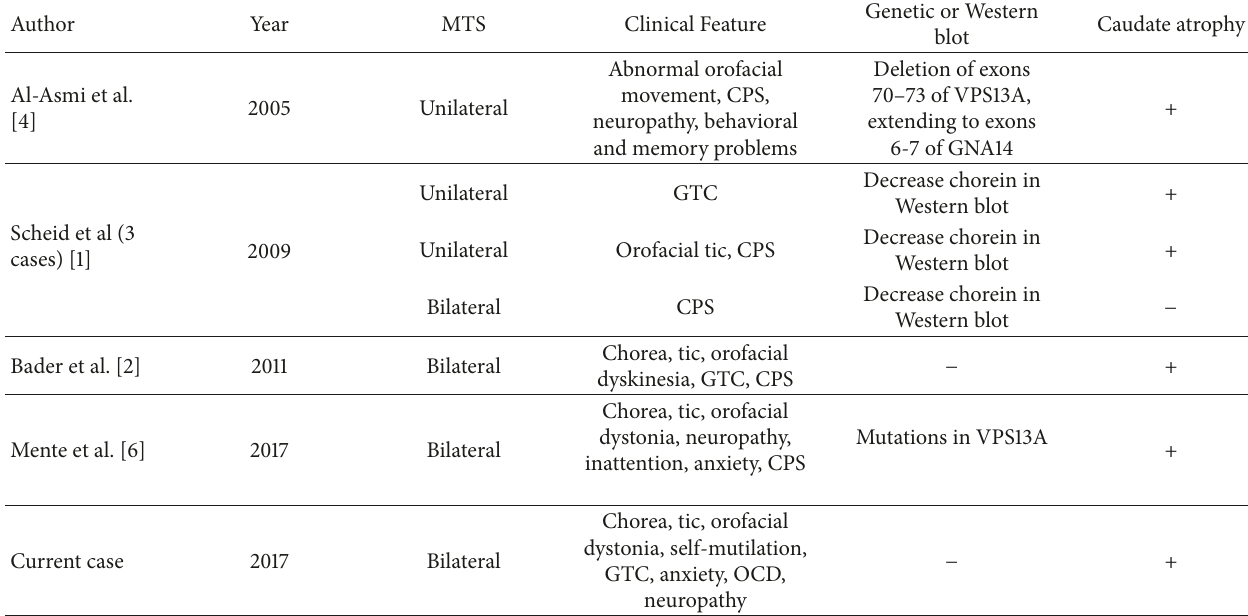
Table 1: Published cases with chorea-acanthocytosis and